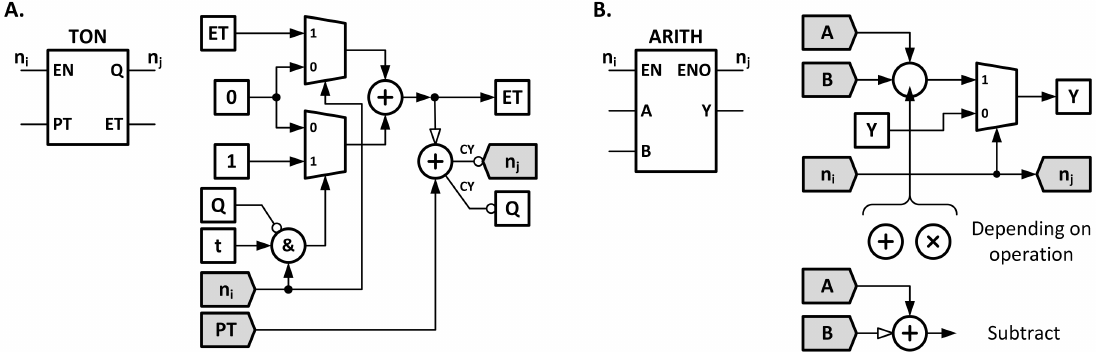
Figure 6. The complex functions components DFG mappings of TON timer ( A ) and arithmetic functions ( B